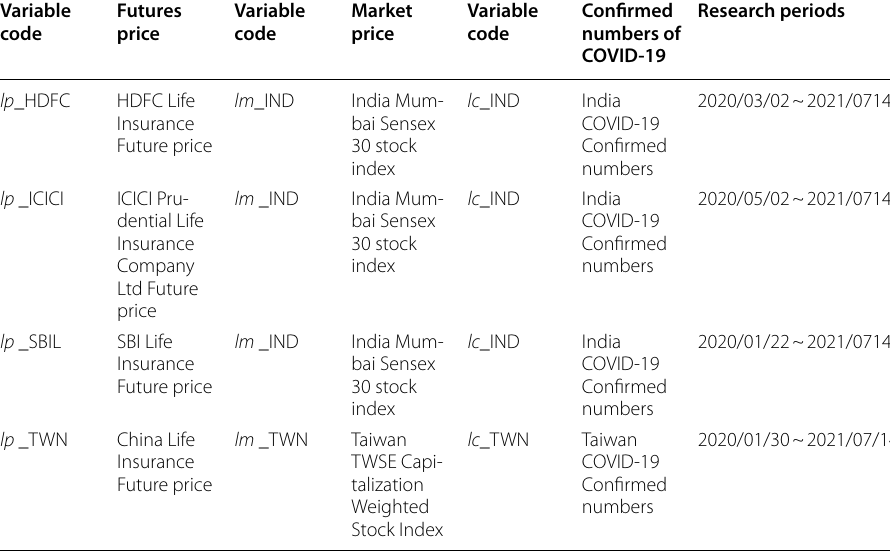
Data sources: Insurance futures price data from the Investing.com financial website database, the stock market index from the TEJ database, and the number of confirmed COVID‑19 cases in the two countries from the Johns Hopkins University Center for Systems Science and Engineering